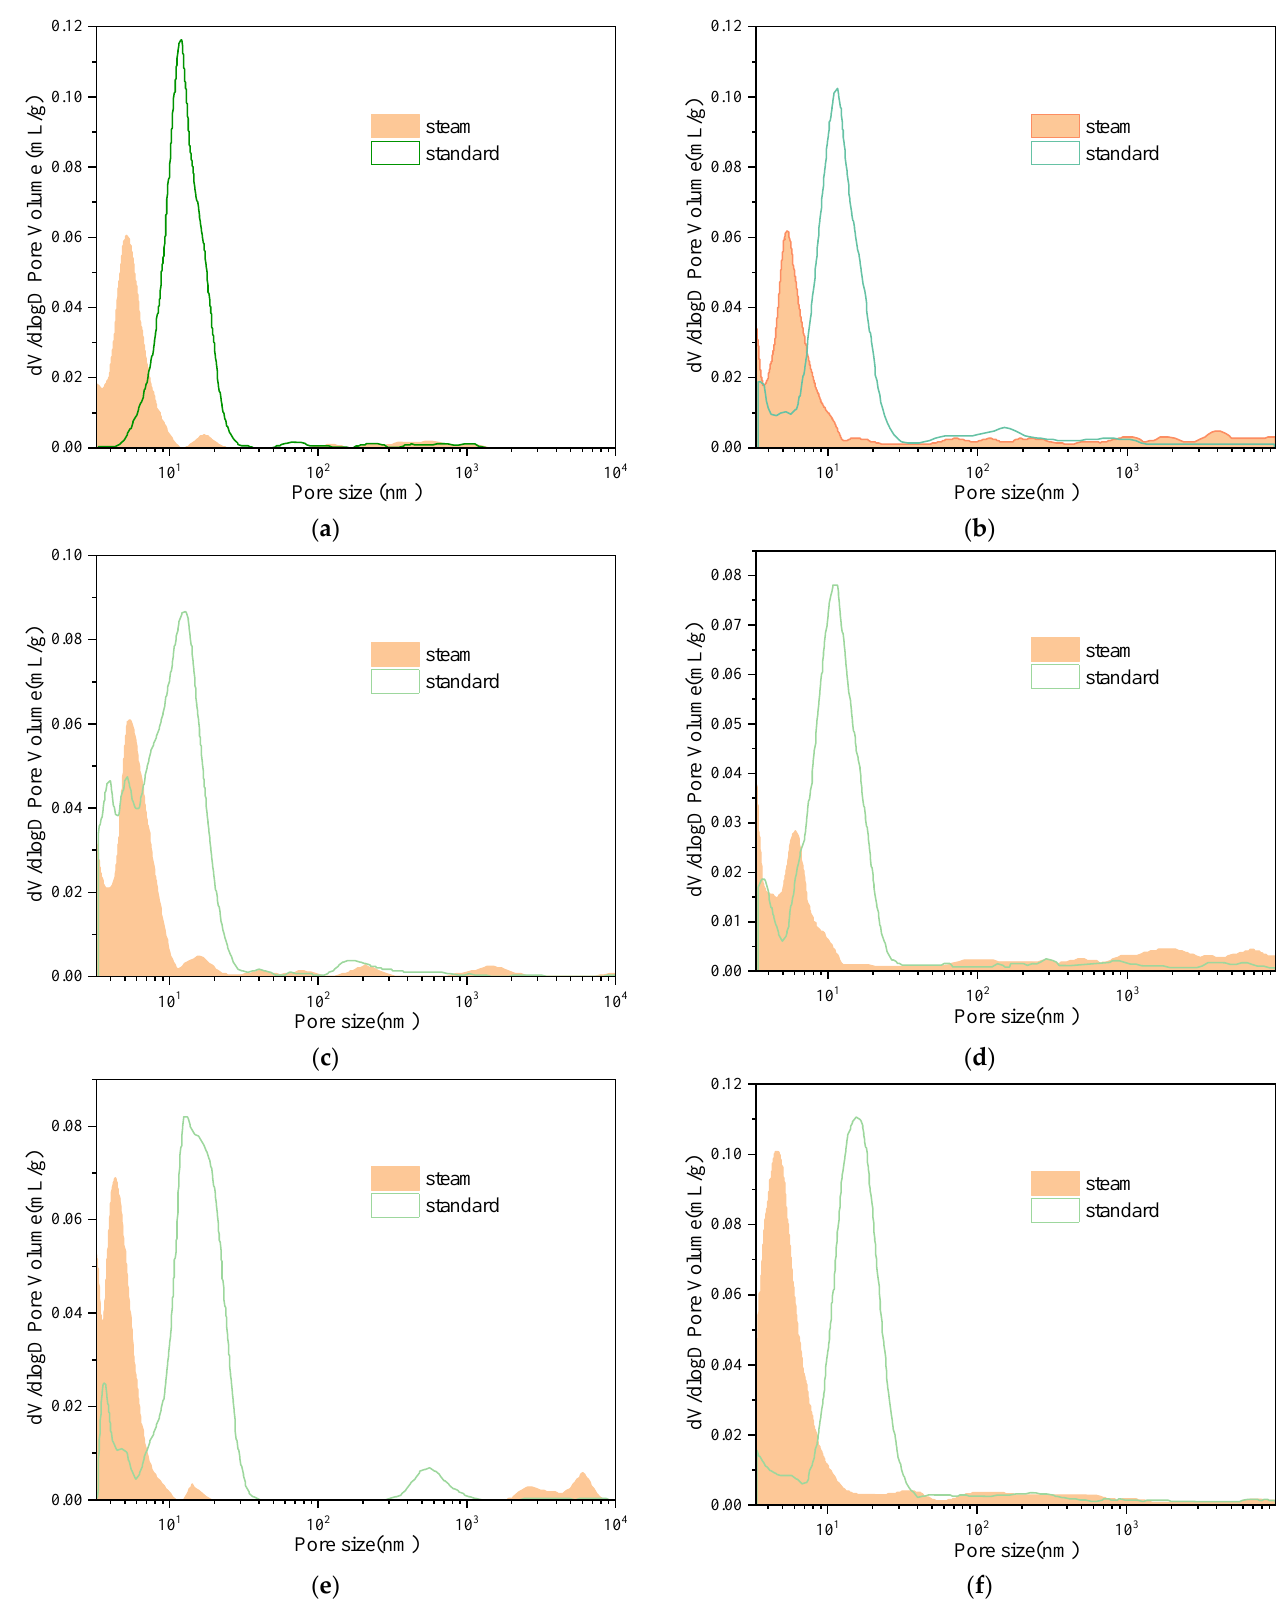
Figure 6. Pore size distribution of EUHPC samples under standard and steam curing: ( a ) S20F0G0; ( b ) S20F10G0; ( c ) S20F10G10; ( d ) S20F0G20; ( e ) S15F15G15; ( f ) S20F0G0*.